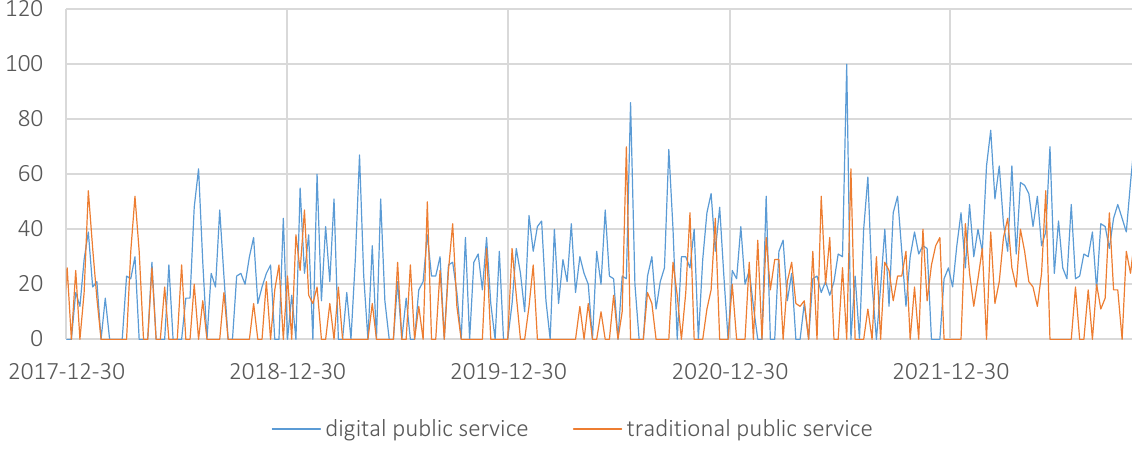
Figure 7. Comparison of Google search queries in trust “Digital public service” AND “Traditional public service”